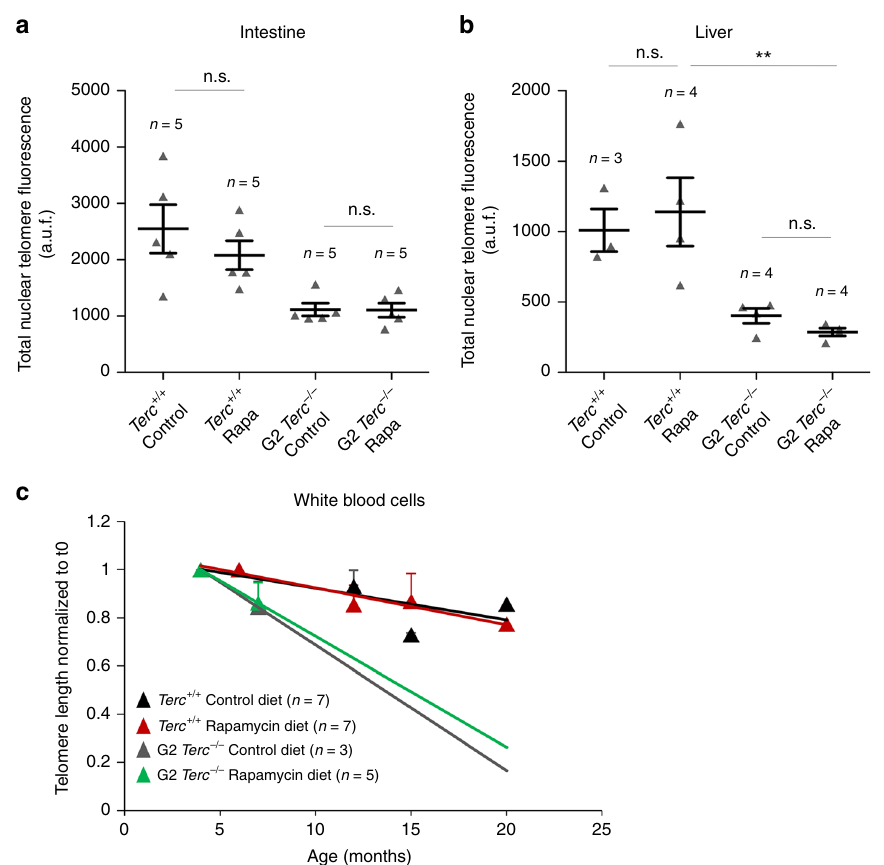
Fig. 2 Rapamycin treatment does not in fl uence telomere length. a , b Total nuclear telomere fl uorescence in intestine ( a ) and liver ( b ) sections of rapamycin- or control-fed Terc + / + and G2 Terc − / − mice at the endpoint, measured by Q-FISH. a.u.f. arbitrary units of fl uorescence. Error bars represent the SE. c Mean telomere fl uorescence in white blood cells from mice of both genotypes at 4.5, 6 – 7, 12 – 15, and 15 – 20 months of age, measured by high throughput Q-FISH. Values and error bars represent the mean and SE, respectively. n = number of mice. Statistical signi fi cance was determined by one-way Anova with post hoc Tukey test. * p ≤ 0.05; ** p ≤ 0.01; *** p ≤ 0.001; n.s. not signi fi cant. Source data are provided as a Source Data fi